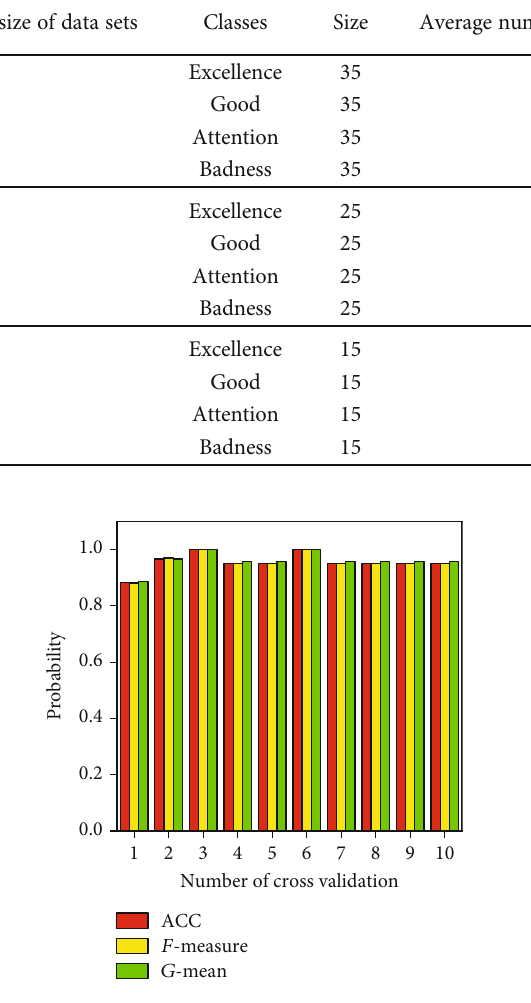
Figure 6: The result based on 10-fold cross-validation.